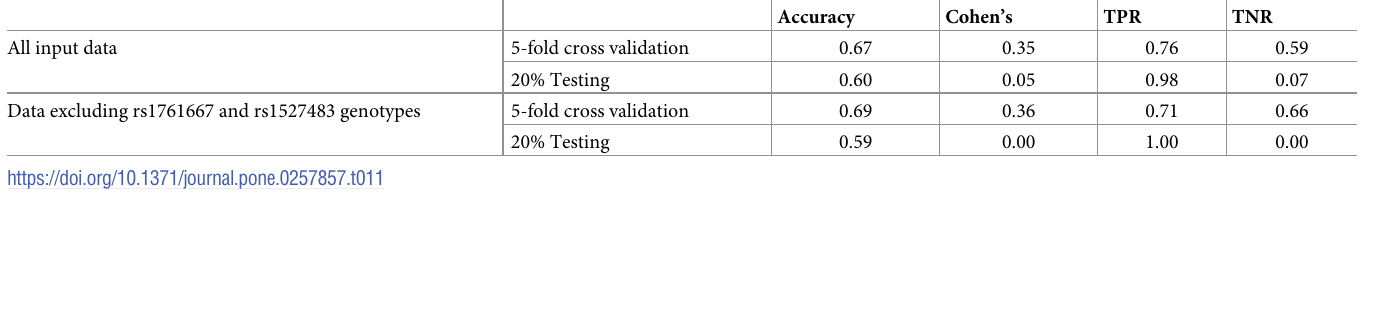
Table 11. Accuracy, cohen’s, TPR, and TNR based on MLP and using either 5-fold cross validation or 20% testing set for prediction people with T2DM from people without dyslipidemia. Logistic All input